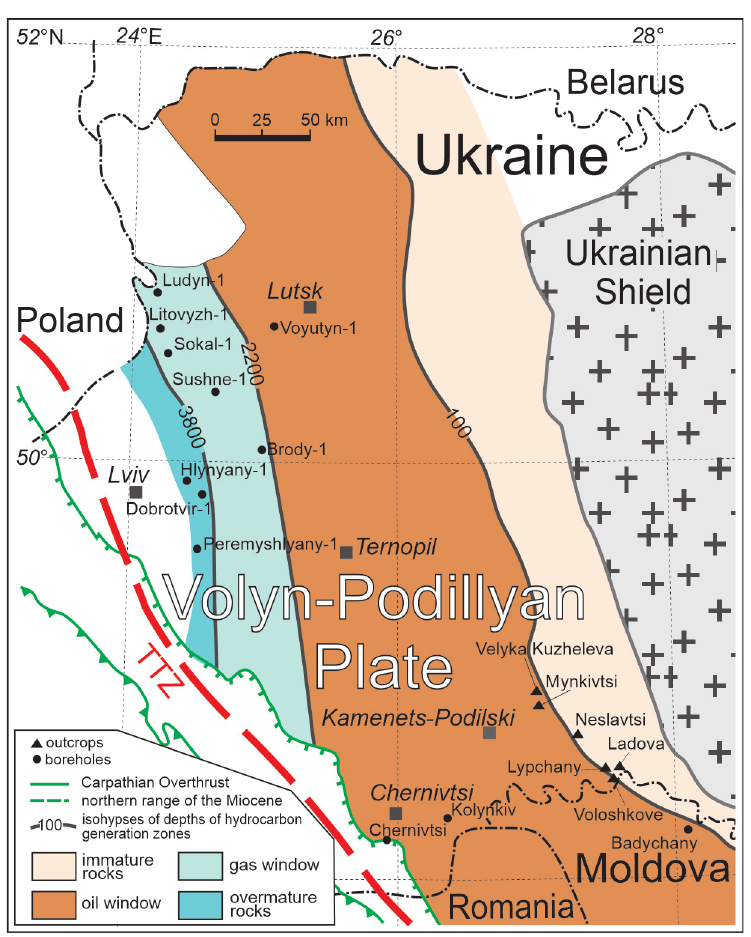
Fig. 10. Extent of hydrocarbon generation windows in the Ediacaran strata within the Volyn-Podillyan Plate and the NW Moldovian Platform. TTZ, Teysseyre-Tornquist